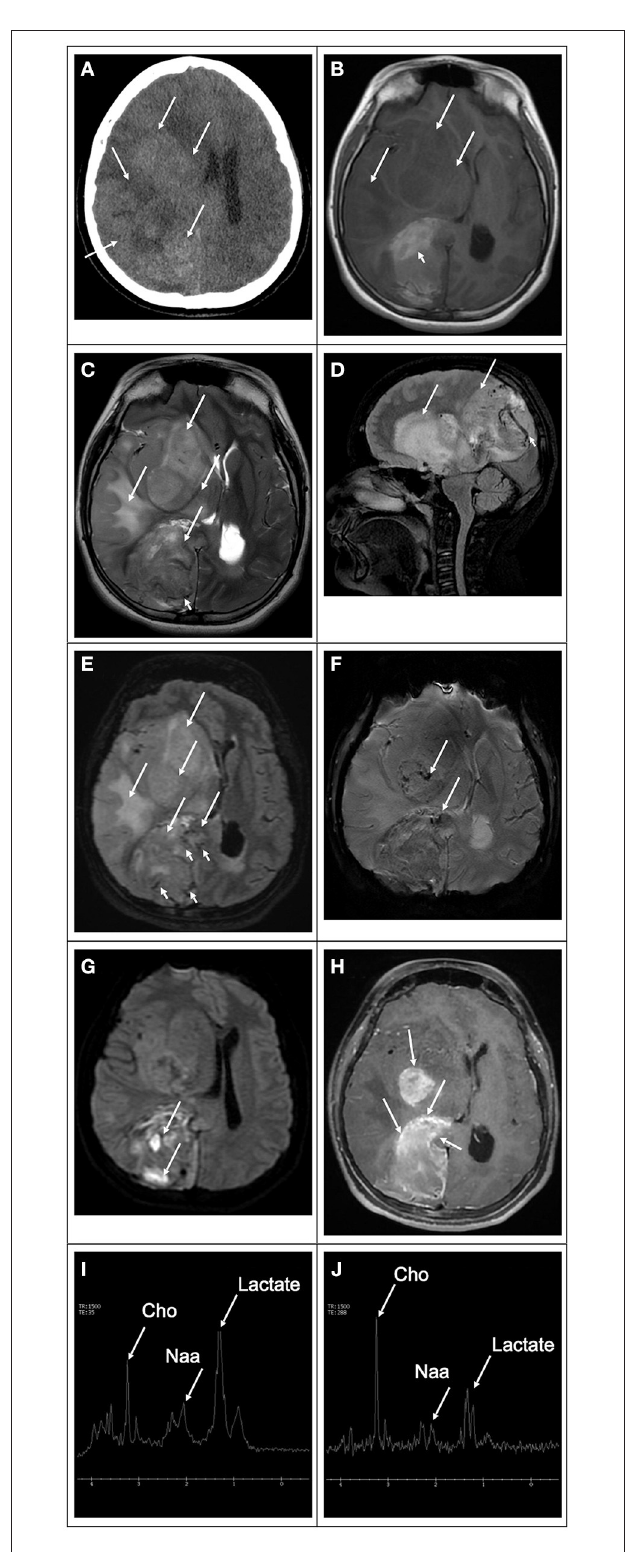
FIGURE 11 | 8-year-old- female with a hemispheric glioblastoma. (A) Computed tomography image in the axial plane shows an extensive mass in